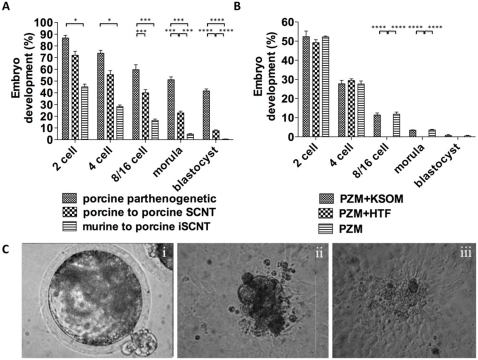
Outcomes from iSCNT.(A) Preimplantation development analysis of murine-porcine and porcine-porcine cloned embryos and porcine parthenogenetic embryos. (B) The effects of different culture systems on the iSCNT embryos in vitro development (PZM - n = 226; PZM+HTF - n = 147; PZM+KSOM - n = 132). (C) In vitro culture of iSCNT embryos: intact embryo with some protrusion (i); proliferating cells from an assisted hatched embryo after 5 days (ii) and 14 days (iii) plated on MEF feeder layers. Data are represented as mean±SEM, * indicates P<0.05, and *** indicates P<0.001 and **** indicates P<0.0001.